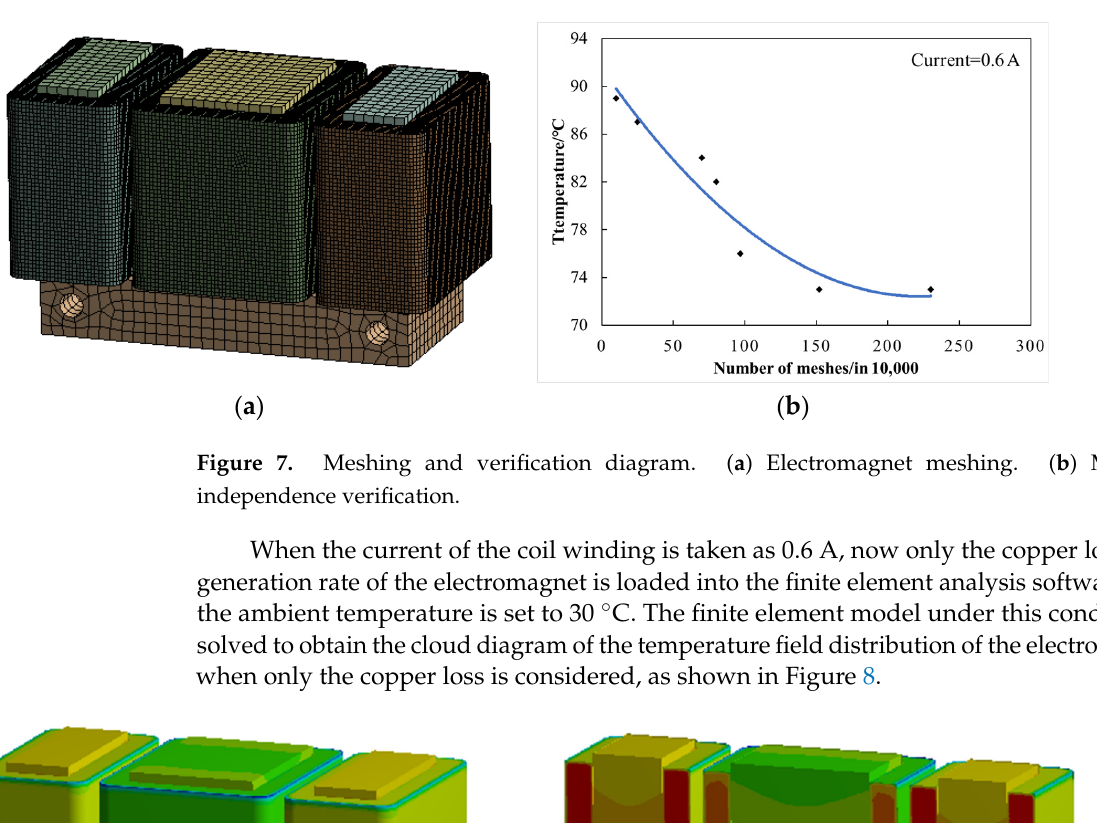
Figure 6. Magnetic thermal coupling analysis flow chart.